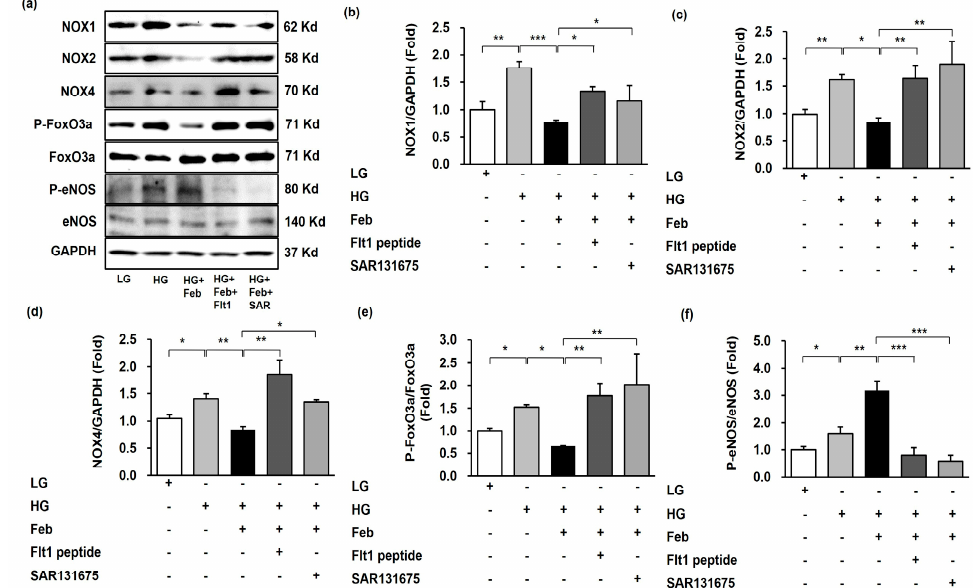
Figure 7. Representative images and quantitative analysis for NOX1, NOX2, NOX4, FoxO3a, and eNOS according to VEGFR1 or VEGFR3 inhibition in HG-treated human GECs with or without febuxostat. ( a ) Representative immunoblot images of NOX1, NOX2, NOX4, FoxO3a and eNOS. ( b ) Quantitative analyses of NOX1/GAPDH. ( c ) Quantitative analyses of NOX2/GAPDH. ( d ) Quan- titative analyses of NOX4/GAPDH. ( e ) Quantitative analyses for phospho-Ser 253 FoxO3a/total FoxO3a. ( f ) Quantitative analyses for phospho-Ser 1173 eNOS/total eNOS. * p < 0.05, ** p < 0.01, and *** p < 0.001, Fit1: anti-Flt1 peptide, SAR: